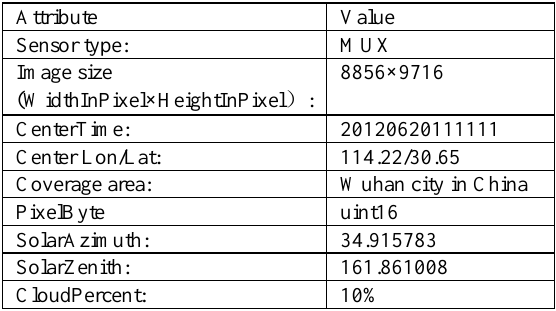
Table 1. The information of one source image used for dataset